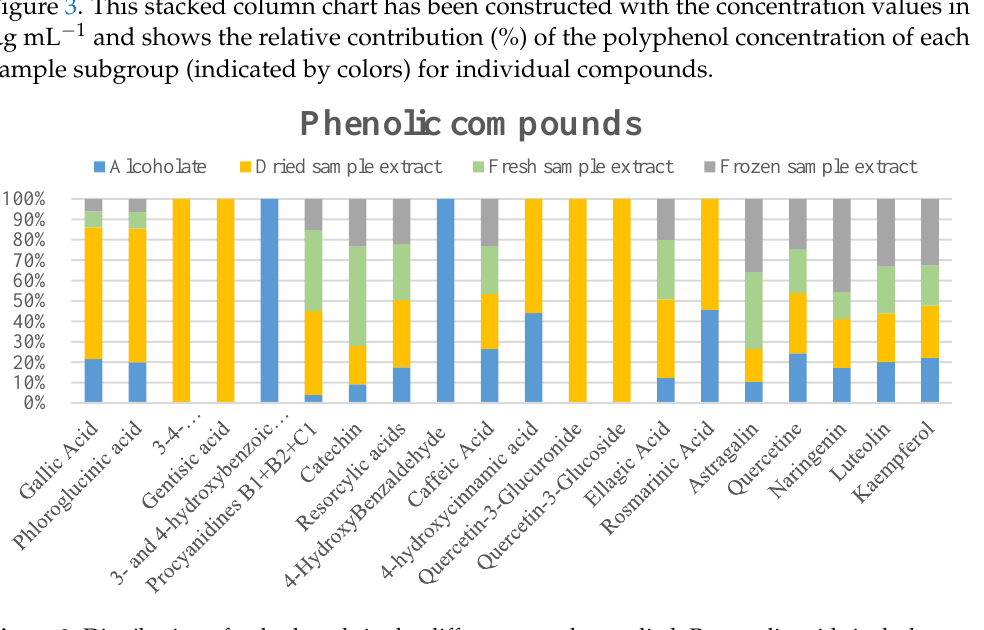
Figure 3. Distribution of polyphenols in the different samples studied. Resorcylic acids include two isomers: α and γ.